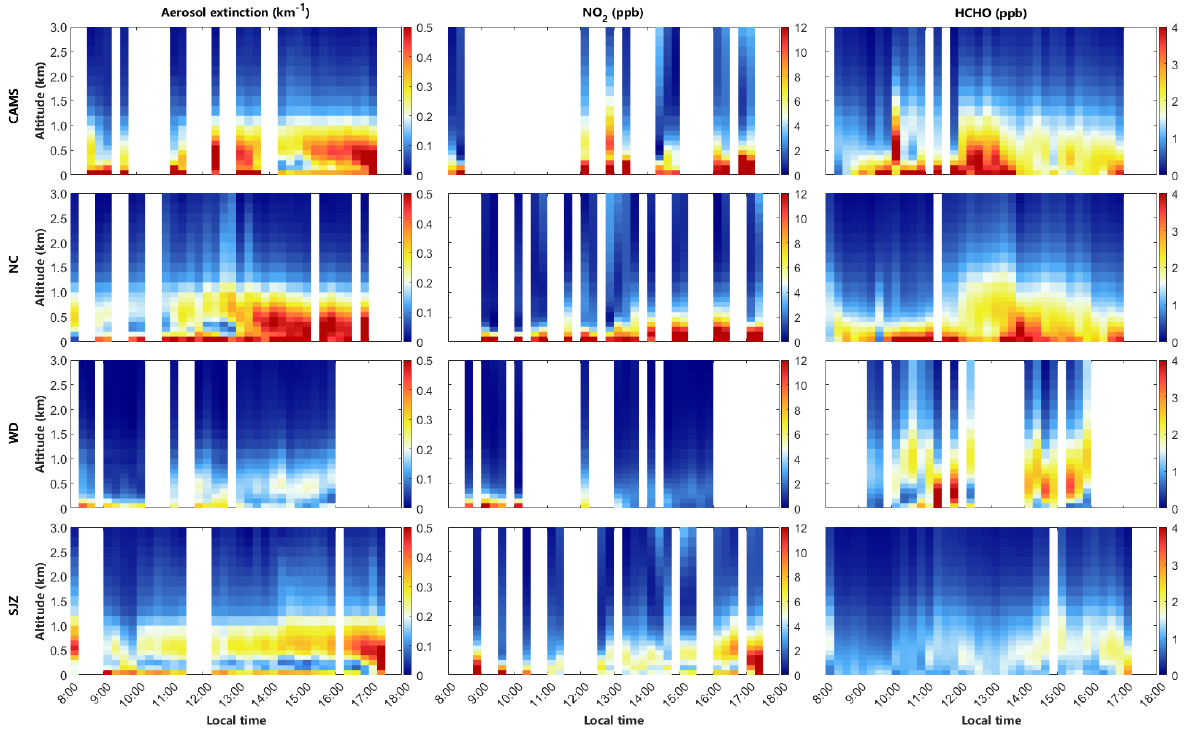
Figure 3. Vertical profiles of aerosols, NO 2 , and HCHO at CAMS, NC, WD, and SJZ stations on 5 February 2021; ppb: part per